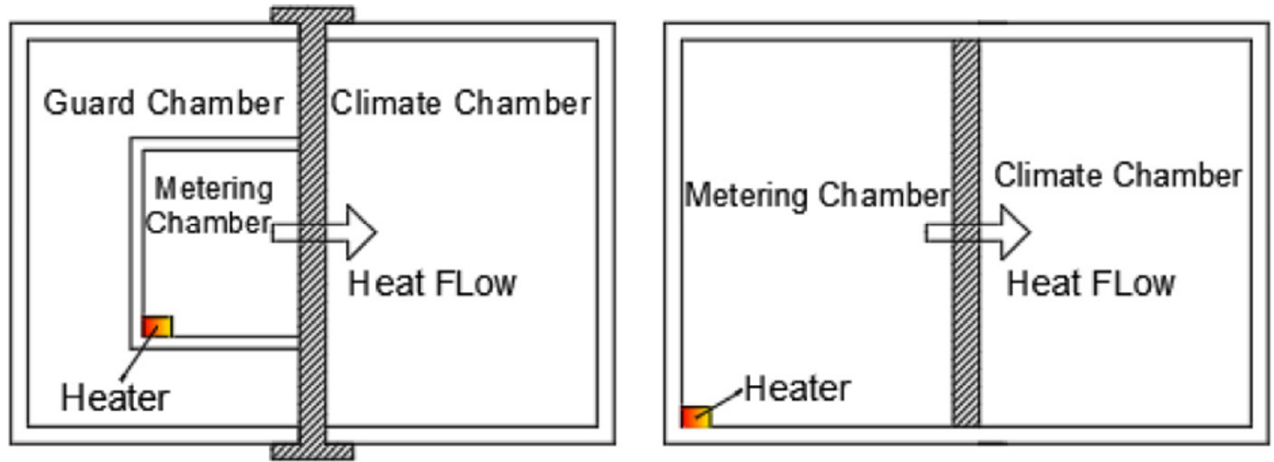
Figure 1. Schematic Hot Box Setup: Guarded Hot Box (left), Calibrated Hot Box (right). According to ASTM C1363, the thermal transmittance 𝑈 is defined as: